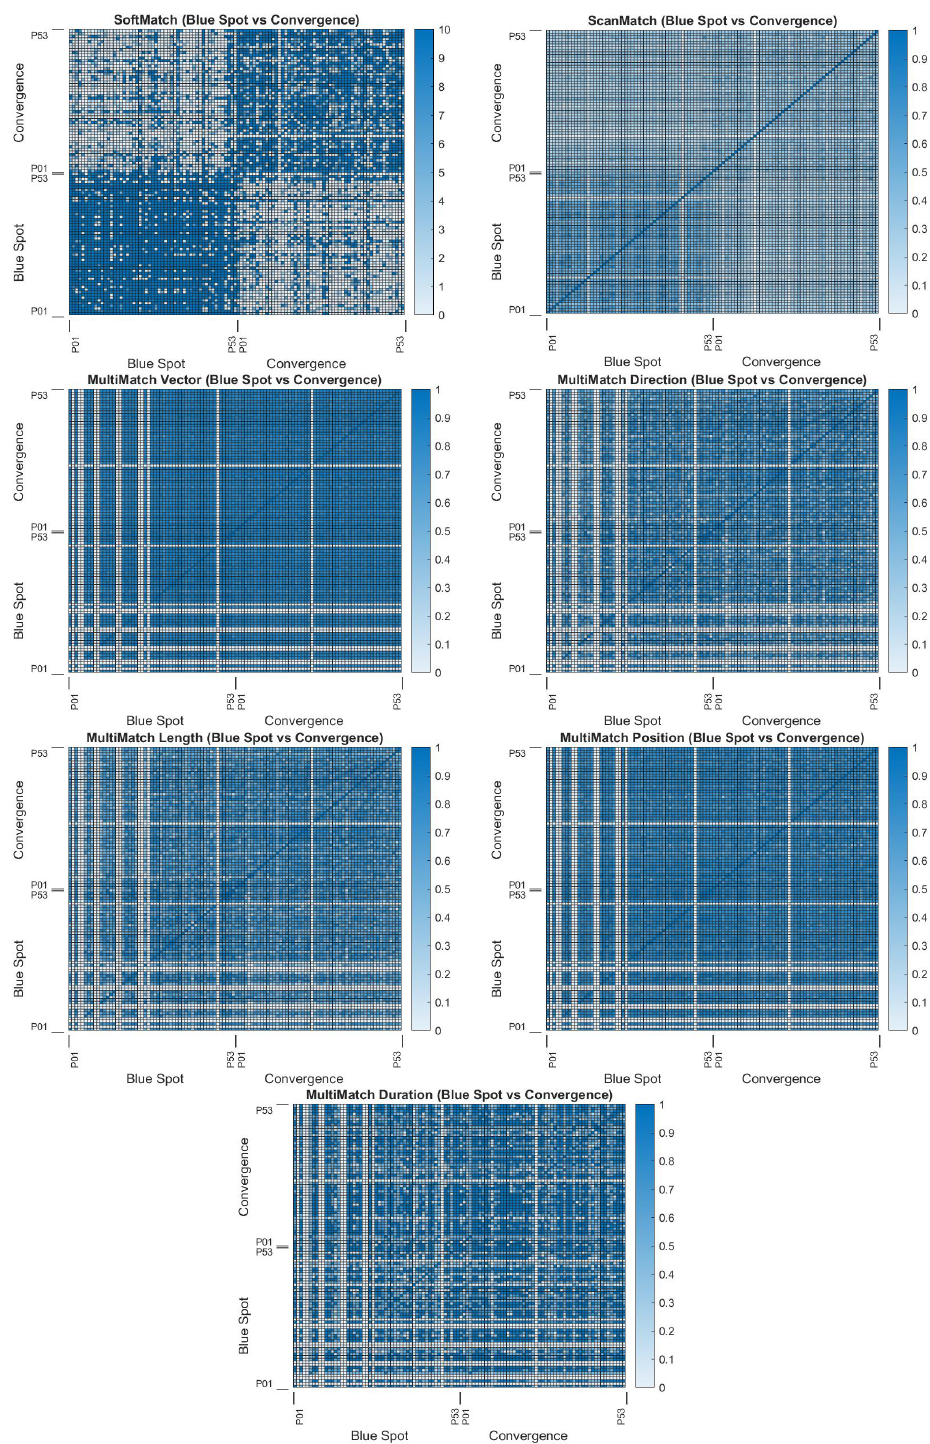
Figure A6. SoftMatch, ScanMatch, and MultiMatch heatmaps for empirical evaluation. Stimuli matched are Bernard Cohen’s Blue Spot (1966) and Jackson Pollock’s Convergence